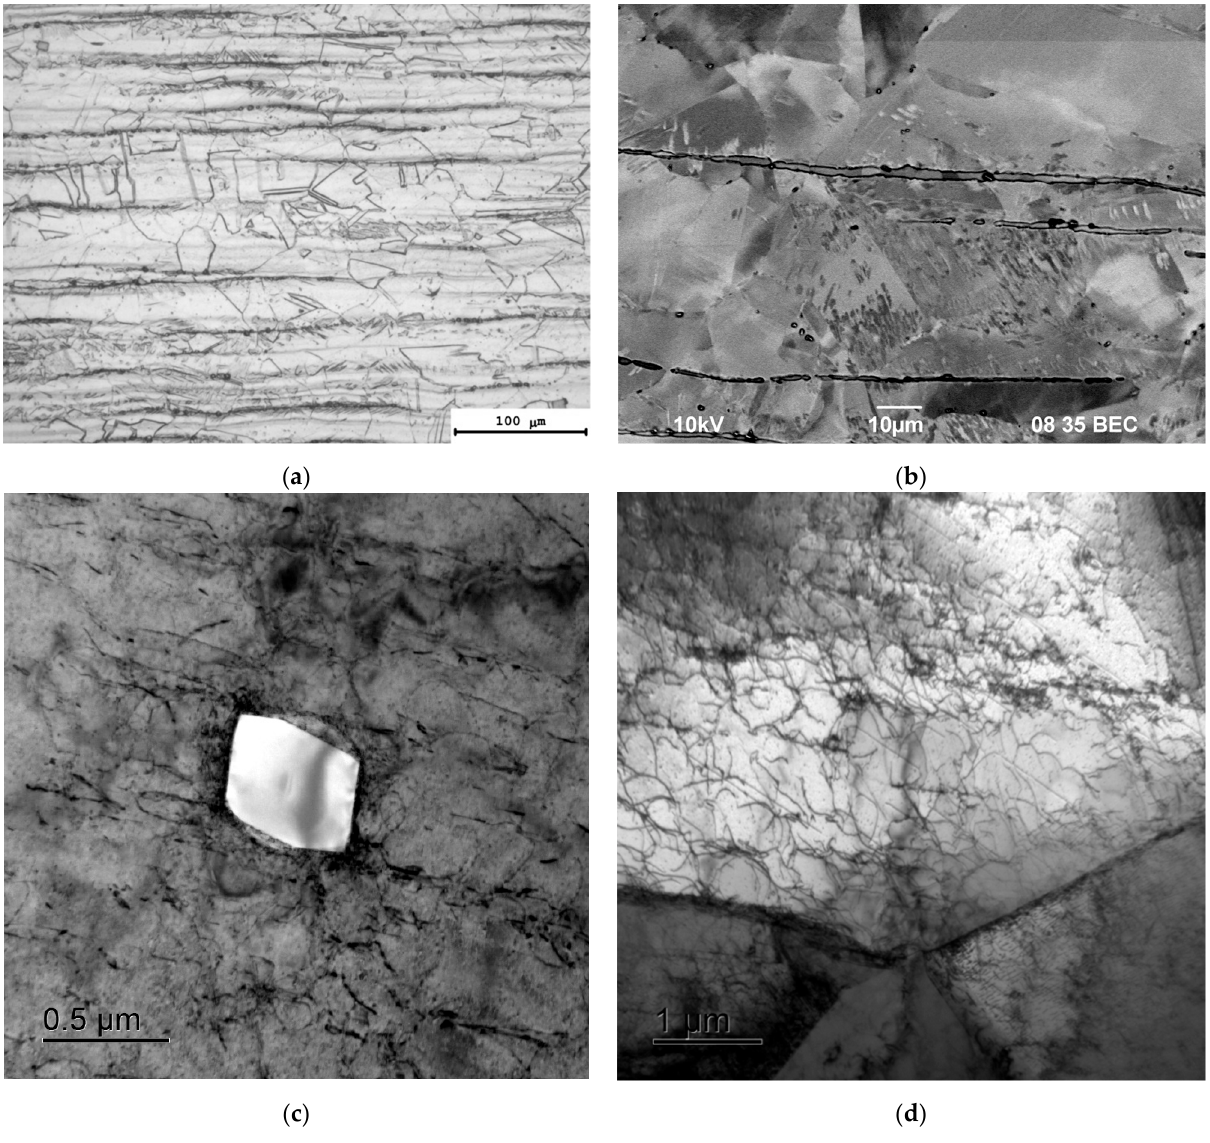
Figure 3. Microstructure of steel in its initial state: ( a , b ) δ -phase particles in steel in its initial state (( a )—optical microscopy; ( b )—SEM); ( c , d ) microstructure of austenite grains (TEM).